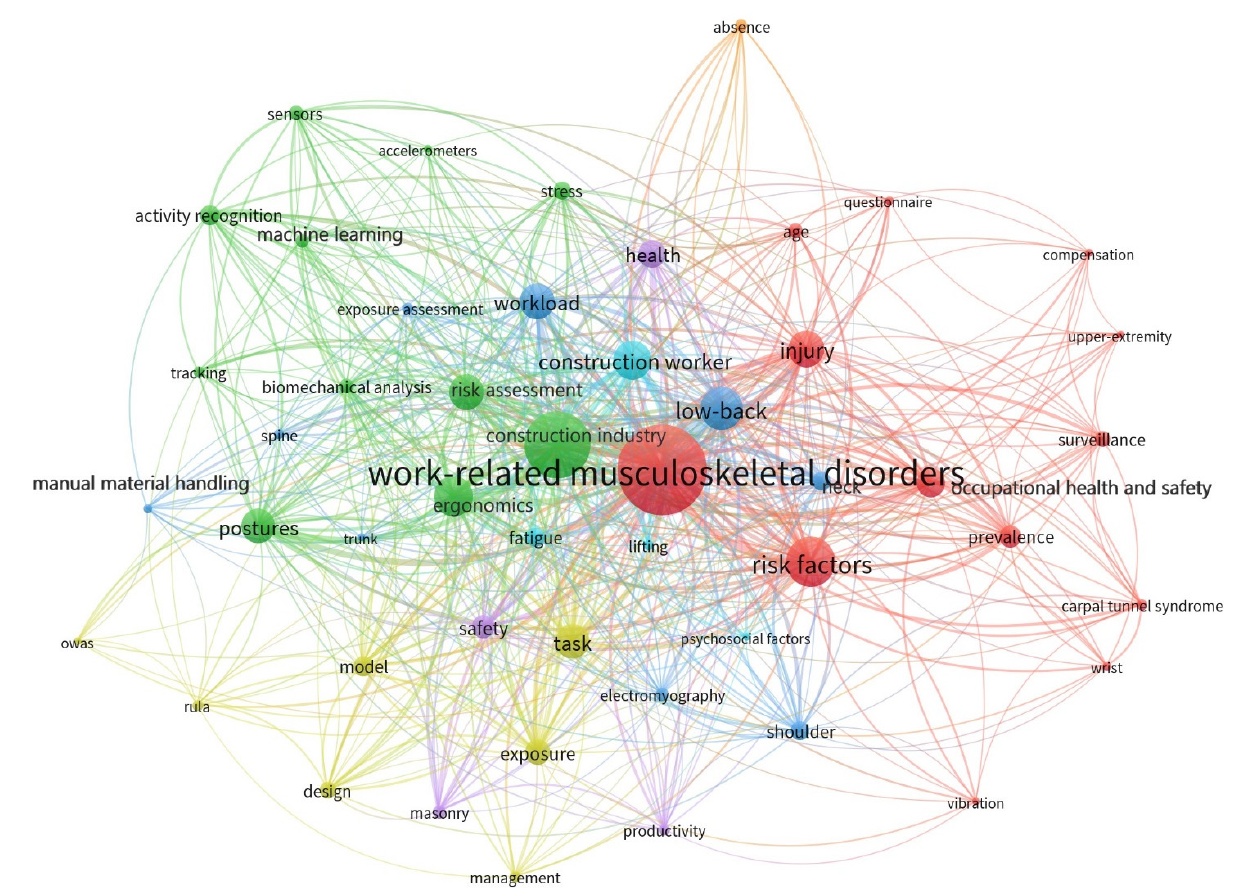
Figure 3. Co-occurrence of keywords.